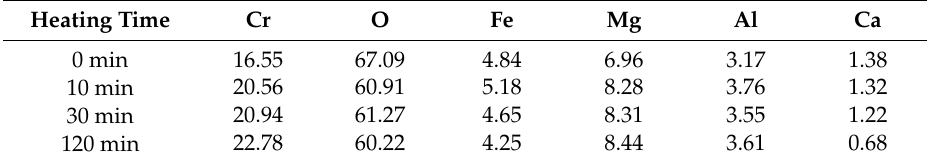
Table 2. Chemical composition of the spinel crystals in Figure 4. Unit = atom%.